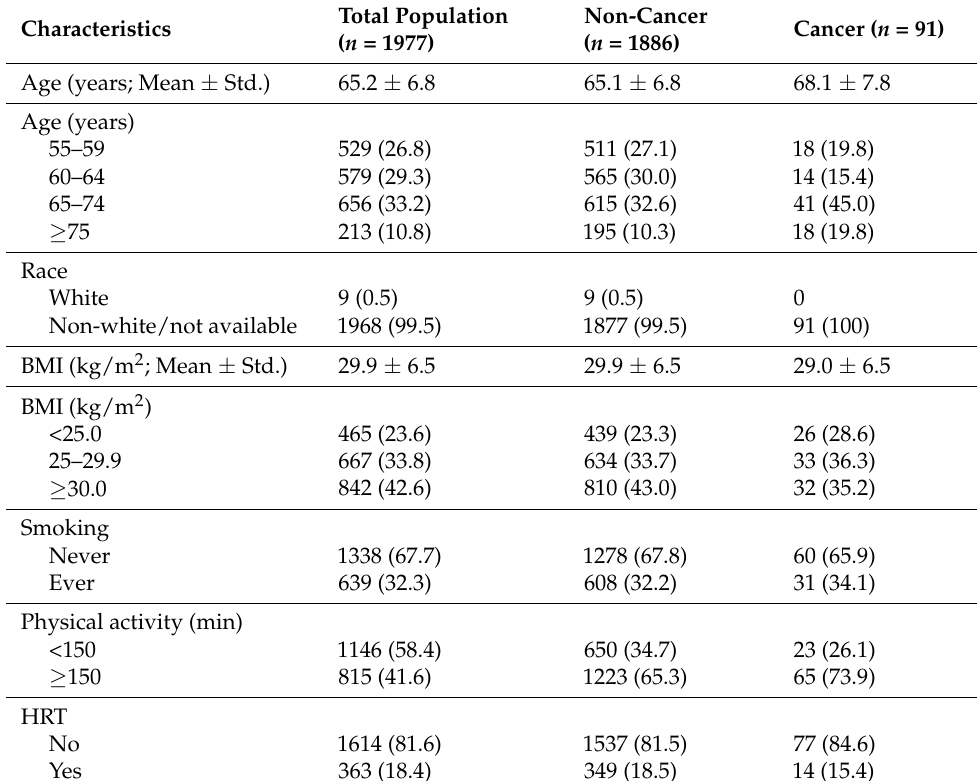
Table 2. Baseline Characteristics of Total Study Population and by Cancer Status.